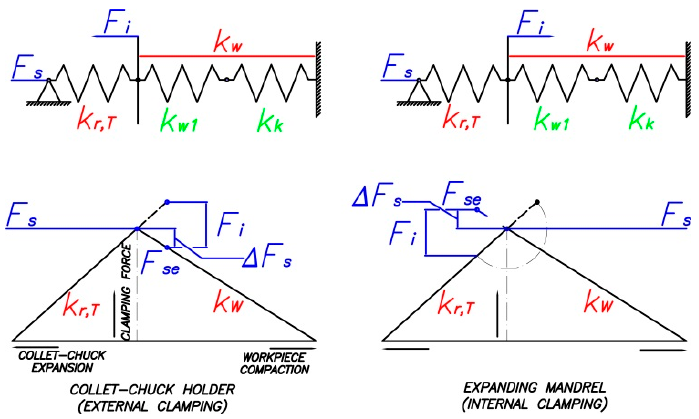
Figure 13. Diagram for determining the variance in the clamping force.